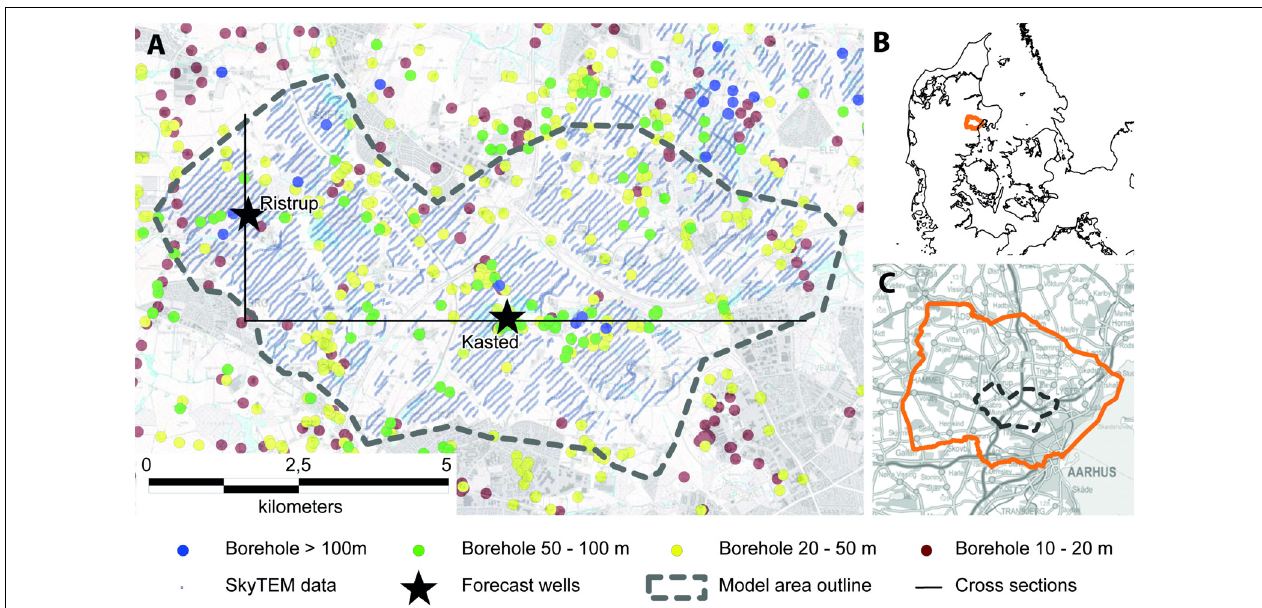
FIGURE 1 | Outline of the investigated area located outside the town of Aarhus, Denmark (A) . Local scale groundwater model imbedded into the regional model setup outlined in (C) . The Regional model is located in the central part of the Jutland peninsula in Denmark (B)